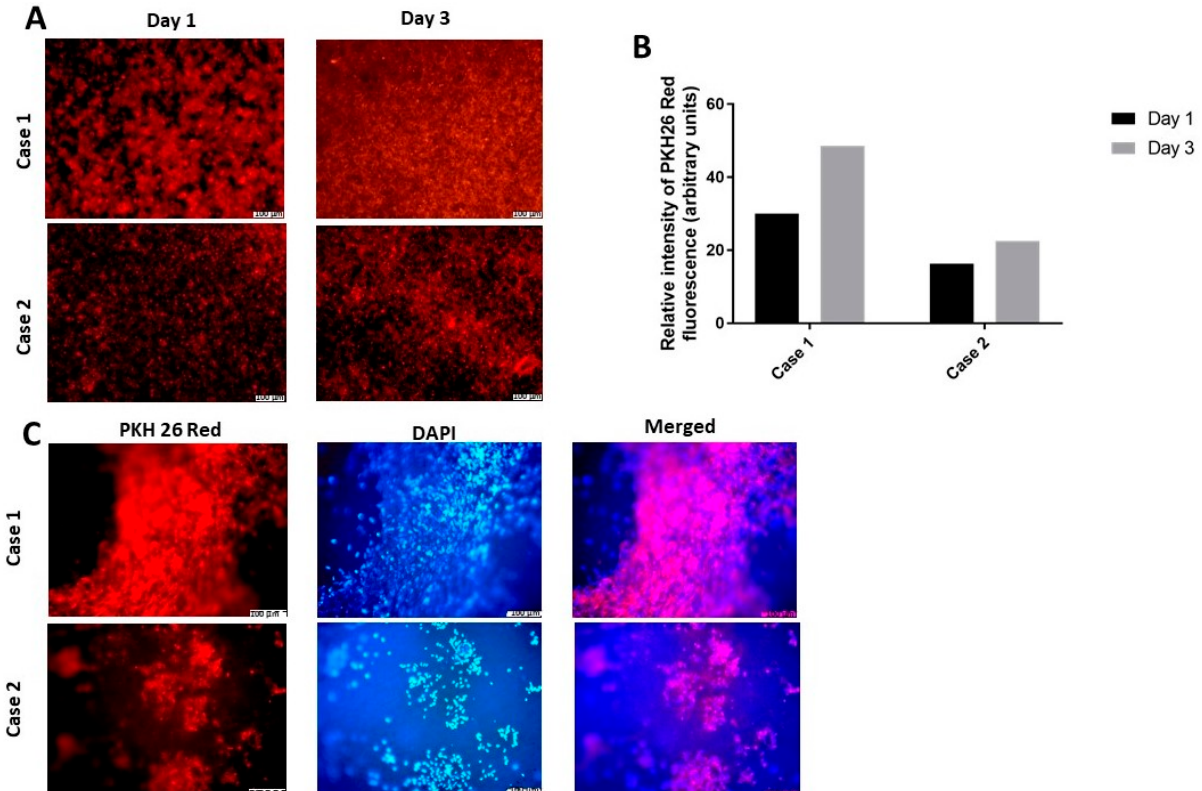
Figure 6. Proliferation activity of hDPSCs obtained from two cases ( A ) representative images of PKH26 red staining for hDPSCs from two cases three days after the scaffold seeding. ( B ) PKH26 red fluorescence intensity quantified on days one and three. ( C ) representative images of hDPSCs moved onto glass coverslips illustrate the extensive live colonies after three days of culture on the scaffold, as confirmed using PKH26 red and DAPI staining. Scale bar = 100 μ m.